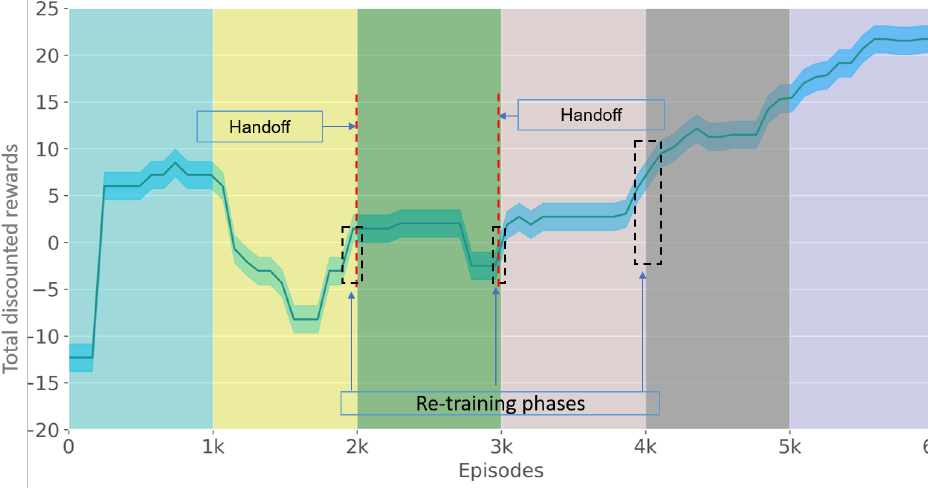
Figure 5. Total discounted rewards achieved at different elevation